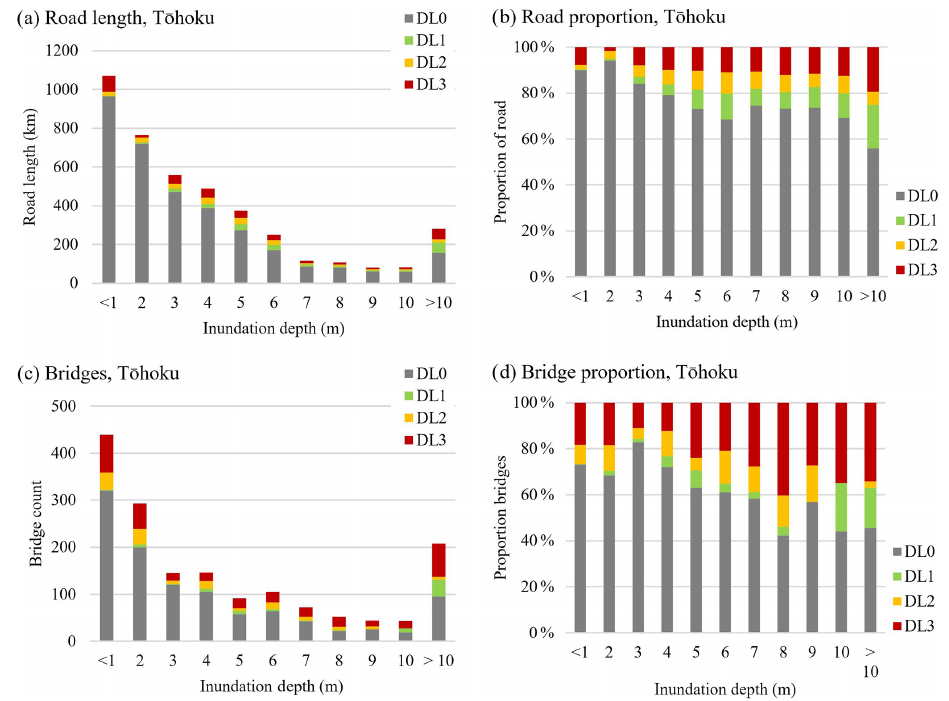
Figure 5. Total length (a) and proportion (b) of exposed roads and number (c) and proportion (d) of exposed bridges, by inundation depth, in Miyagi and Iwate prefectures for the 2011 T¯ohoku earthquake and